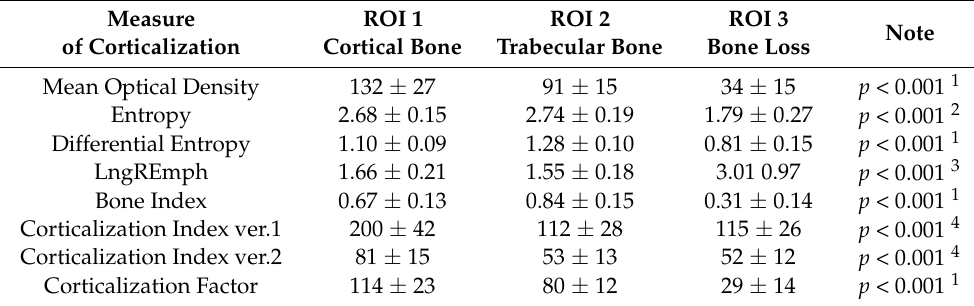
Table 1. Numerical results of the investigation of selected measures of corticalization.